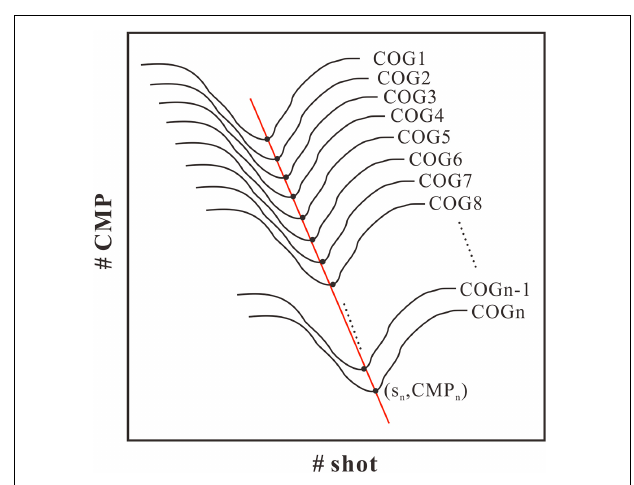
the front and rear edges of the internal solitary wave. Seismic